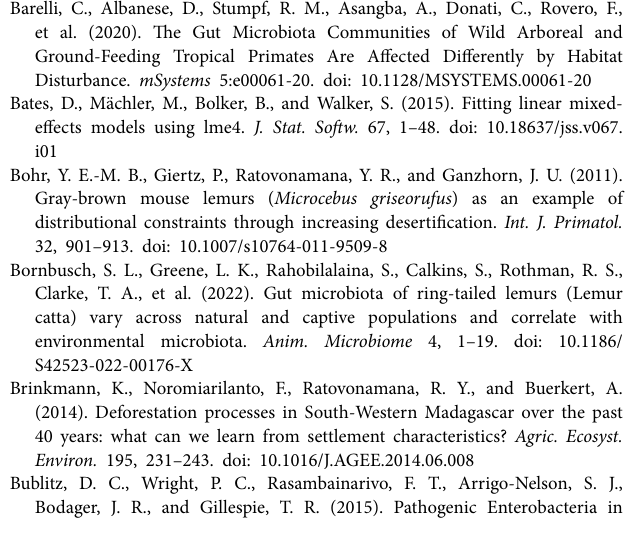
Supplementary Figure 1 | Differential abundance of predicted major functional pathways in relation to the habitat of mouse lemurs. Differences in the mean abundance of major functional pathways (by using KEGG classification) between Andranovao and Miarintsoa individuals (Wald tests, p ≤ 0.05). The values indicate a log 2-fold decrease or increase in Miarintsoa individuals. Functional pathways are arranged according to increasing values of log 2-fold